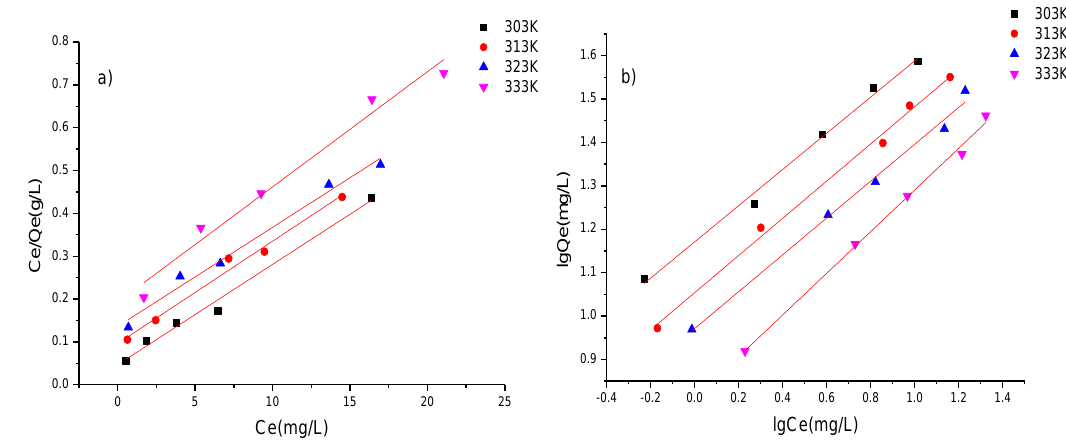
Figure 8. The equilibrium isotherms for MB adsorbed by 6-EA-β-CD-Si: ( a ) the Langmuir model; ( b ) the Freundlich model. Table 3. Langmuir and Freundlich isotherm fitting parameters at different temperatures. Langmuir Adsorption Isotherm Freundlich Adsorption Isotherm T(K) Qmax